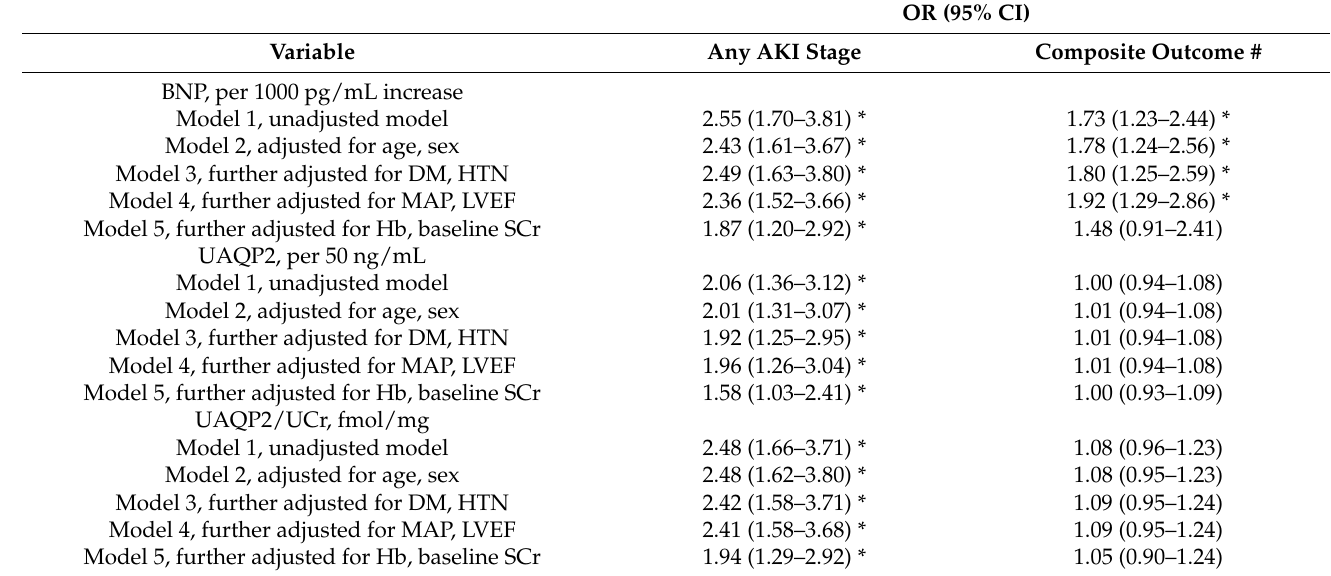
Table 3. Association of BNP, UAQP2, and UAQP2/Cr with the risk of AKI and the composite of AKI stage 3 and in-hospital mortality.